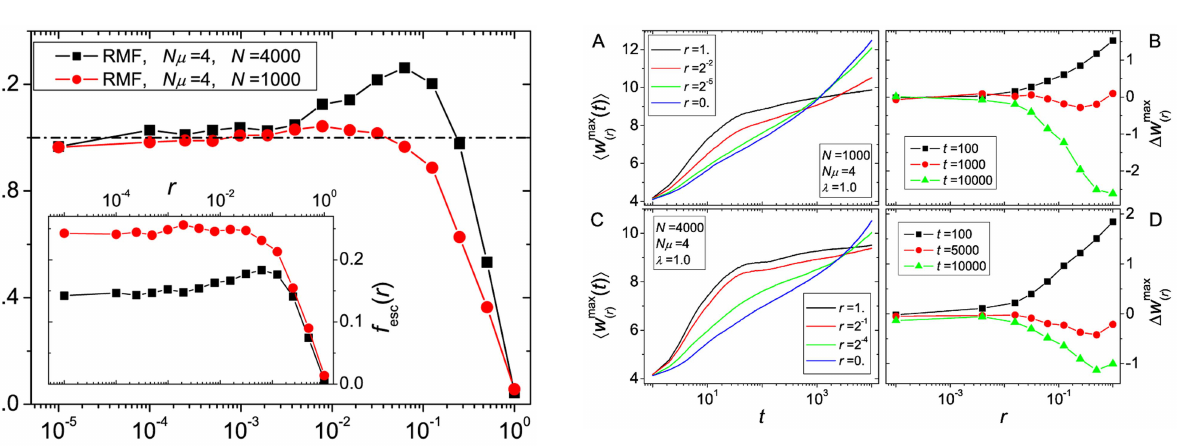
Figure 6. Recombinational advantage as a function of recom- bination rate and observation time. (A) and (C): Fitness of the vs. time for various choices of the recombination fittest genotype w max ( r ) rate r . Parameters correspond to those presented in fig. 5. For short grows more rapidly for large r but at long times w max grows times w max ( r ) ( r ) faster for small r . At intermediate times the acquired fitness depends non-monotonically on r . (B) and (D): D w max vs. r for various choices ( r )